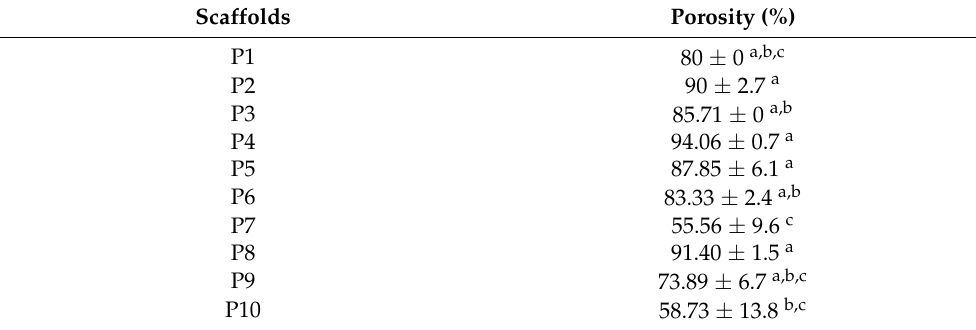
Table 2. Porosities of Samples